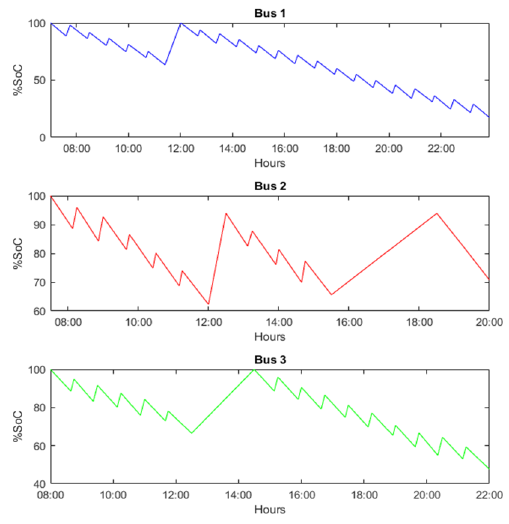
Figure 17. SOC of the three buses with two Opp Chargers of 300 kW.